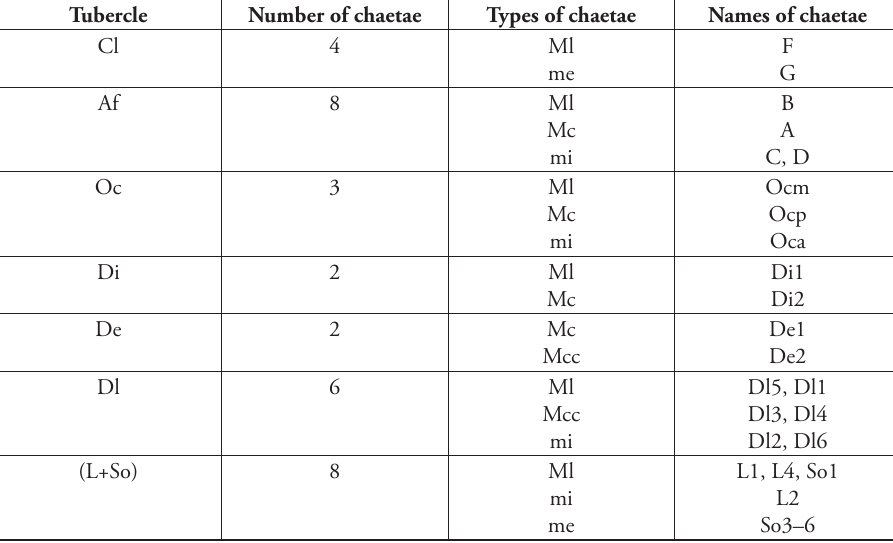
Table 2a. Chaetotaxy of Endonura paracentaurea sp. n.: cephalic chaetotaxy dorsal side. Tubercle